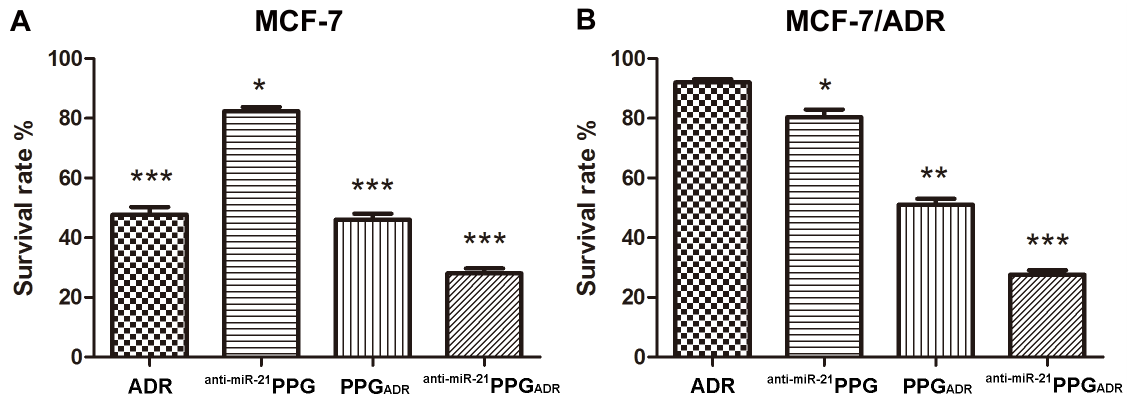
Figure 5. Invitro cellular cytotoxicity. Relative survival rate of MCF-7 cells (A) and MCF-7/ADR cells (B) after being treated with ADR, anti-miR-21 PPG, PPG ADR and anti-miR-21 PPG ADR for 24 h. Untreated MCF-7 and MCF-7/ADR cells were served as control in each experiment. Data are means 6 SD for three separate experiments, * P , 0.05, ** P , 0.01, *** P , 0.001.